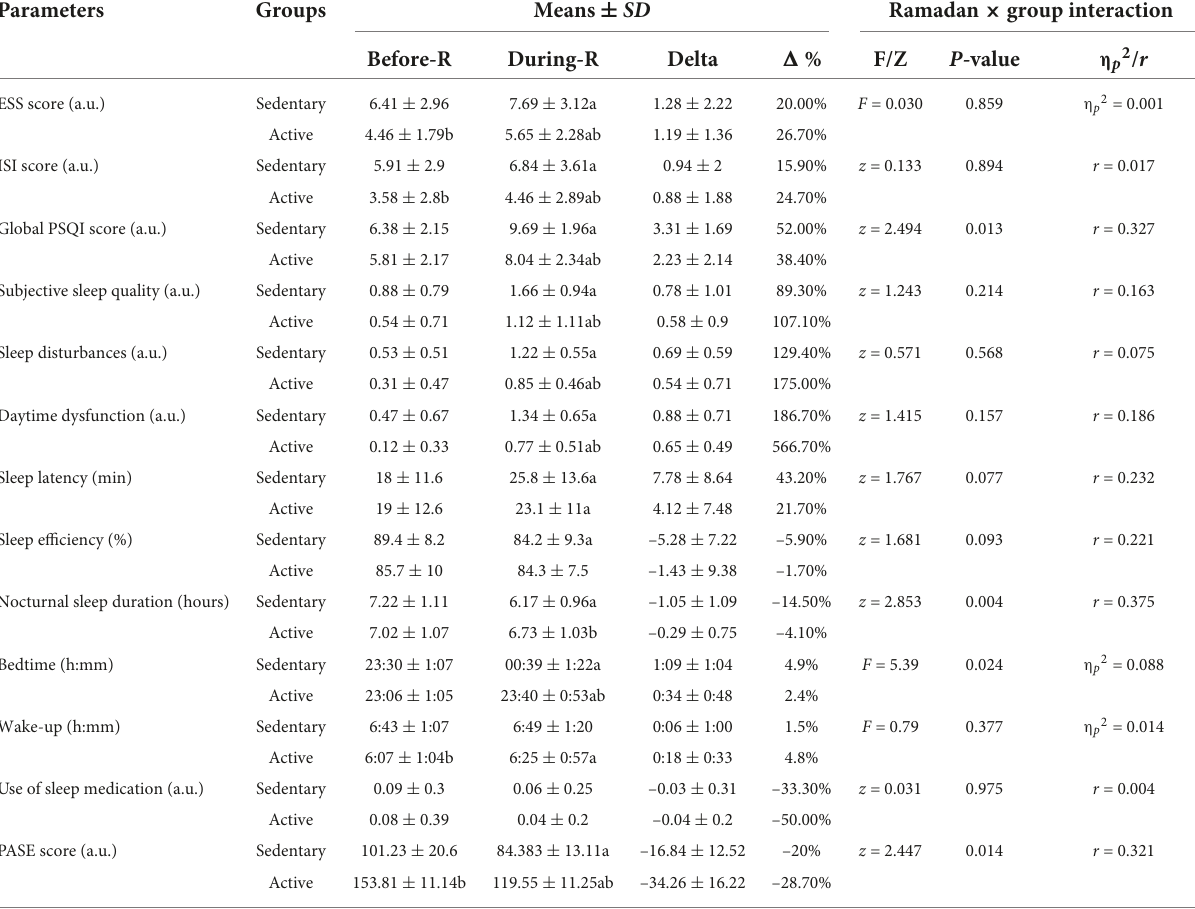
a: significantly different from before Ramadan at p < 0.05; b: significantly different from sedentary group at p < 0.05. Before-R, before Ramadan; During-R, during Ramadan; PSQI, Pittsburgh Sleep Quality Index; ESS, Epworth sleepiness scale; ISI, insomnia severity index; PASE, Physical activity scale for elderly; (cid:49) , difference between during and before Ramadan; SD